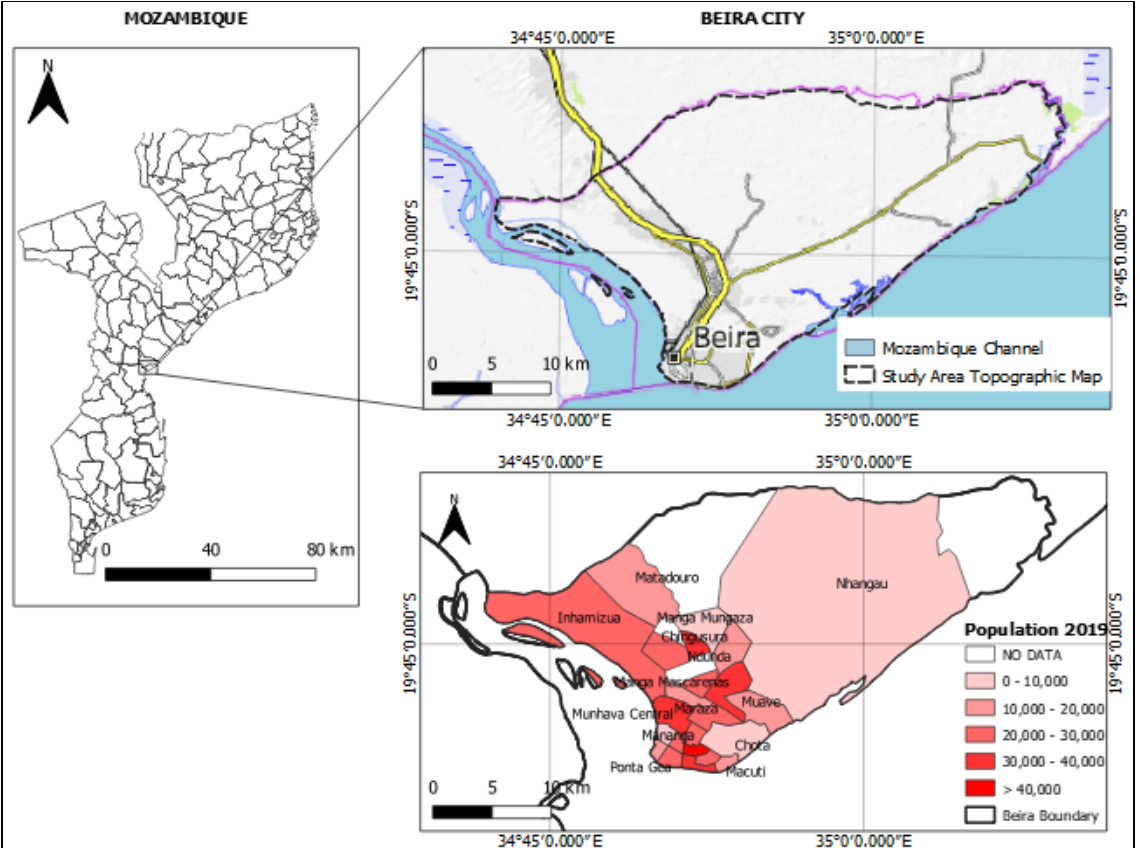
Figure 2. Study area—Beira city and its neighborhood